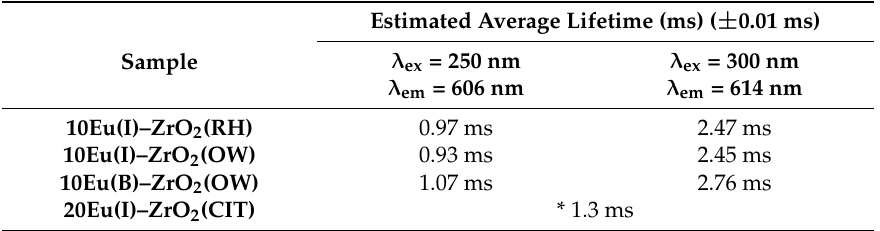
Table 2. Average lifetimes of 10Eu(I)–ZrO 2 (OW, RH) and 20Eu(I)–ZrO 2 (CIT) annealed at 1000 ◦ C estimated from the emission decays displayed in Figure